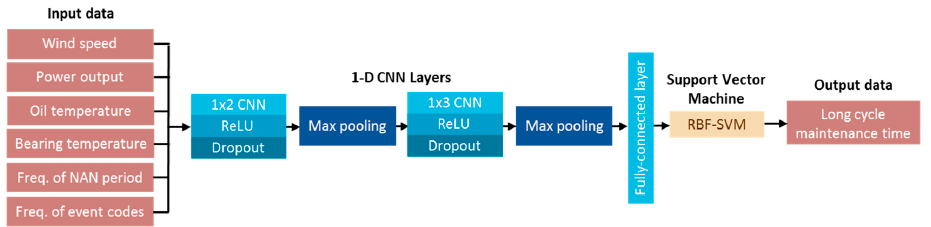
Figure 8. The architecture of the hybrid network.